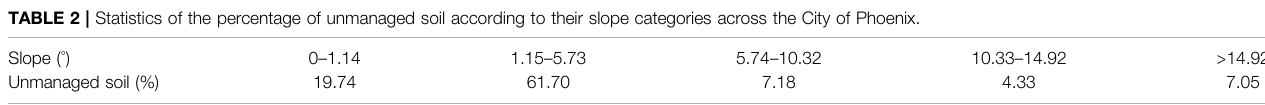
TABLE 2 | Statistics of the percentage of unmanaged soil according to their slope categories across the City of Phoenix. Slope ( °